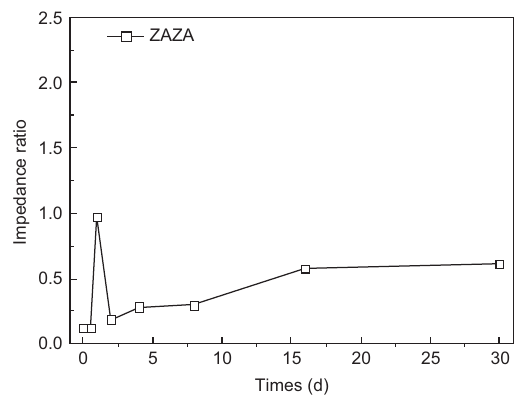
Figure 4 Impedance ratio of sealed ZAZA coatings to the metal coating + organic coating over time.